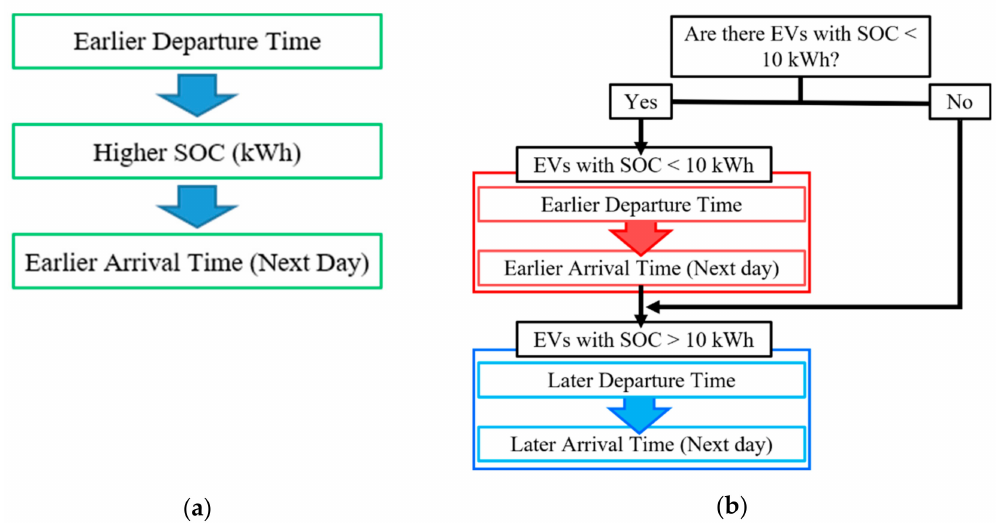
Figure 10. Formulated EV charging and discharging priority schemes: ( a ) discharging priority scheme and ( b ) charging priority